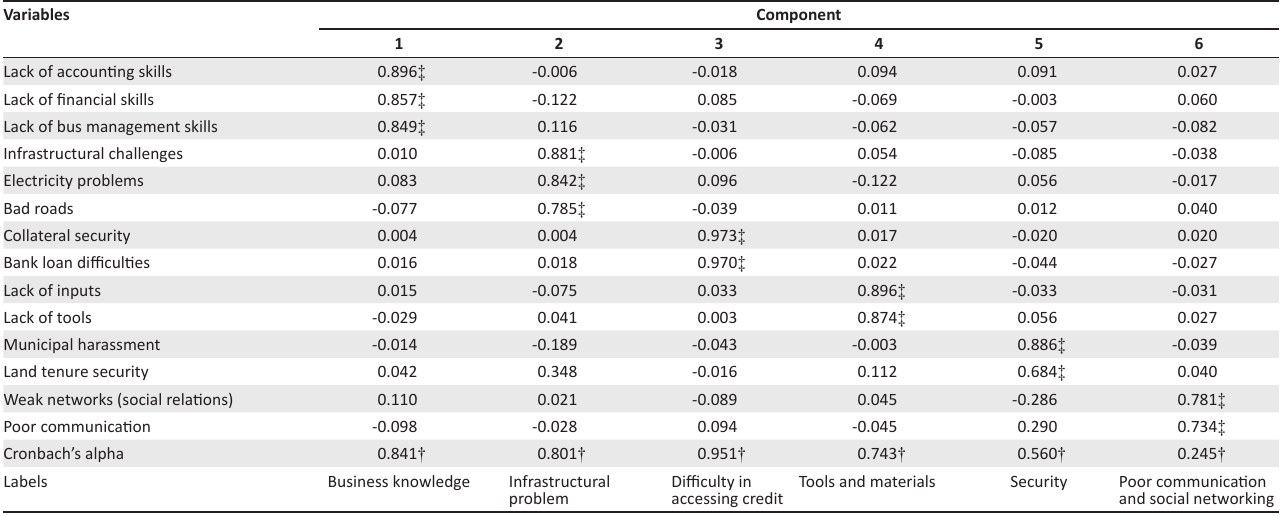
TABLE 4: Rotated matrix.